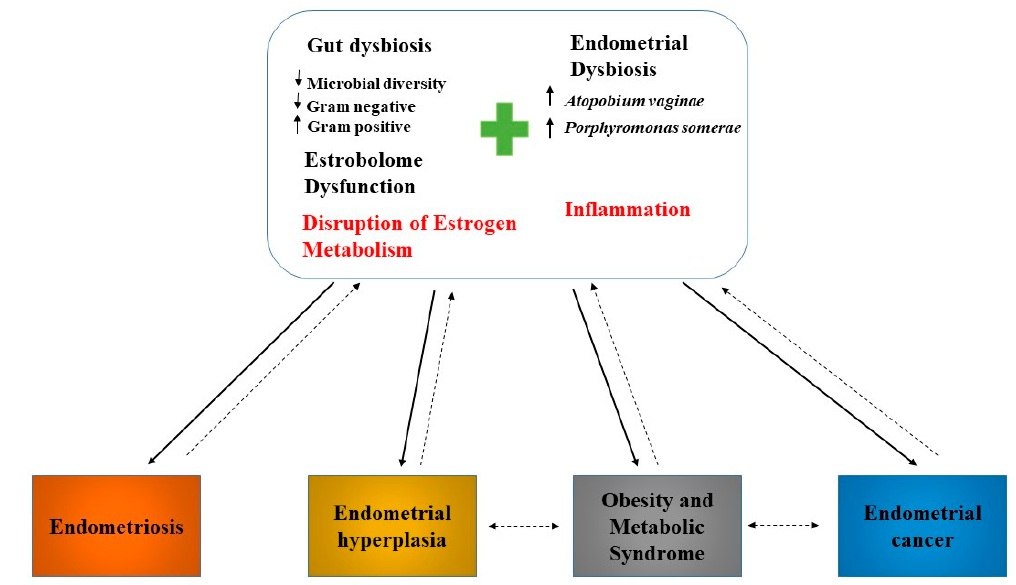
Figure 3. Endometrial and gut dysbiosis implication in endometrial cancer induction. The simultaneous presence of Atopobium vaginae and Porphyromonas somerae in the endometrium induce the production of pro-inflammatory cytokines, which are involved in endometrial carcinogenesis and other endometrial diseases.